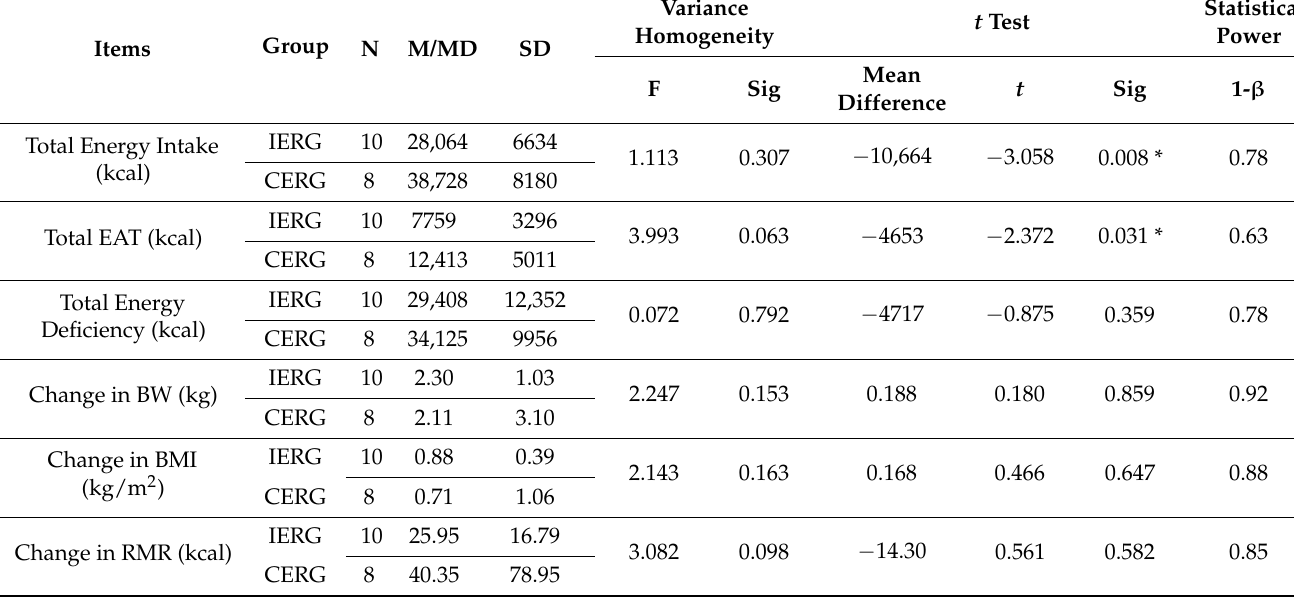
Table 3. The details of energy balance and the result of the Student’s t test between groups with its statistical power.